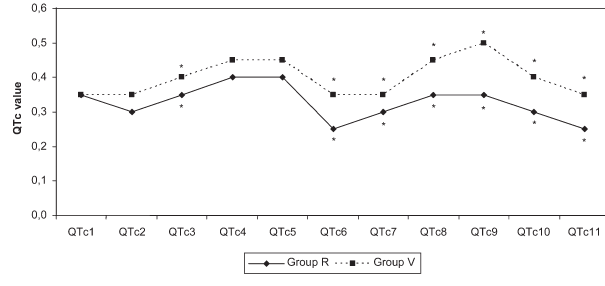
Figure 3 - QTc values in the two study groups (seconds).